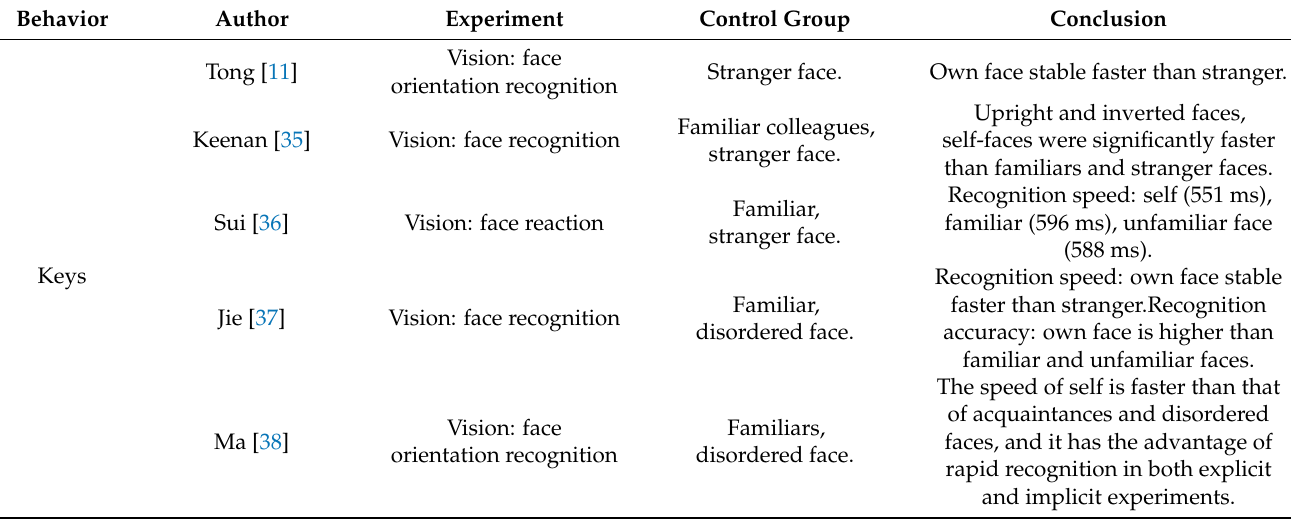
Table 1. Behavioral priority of